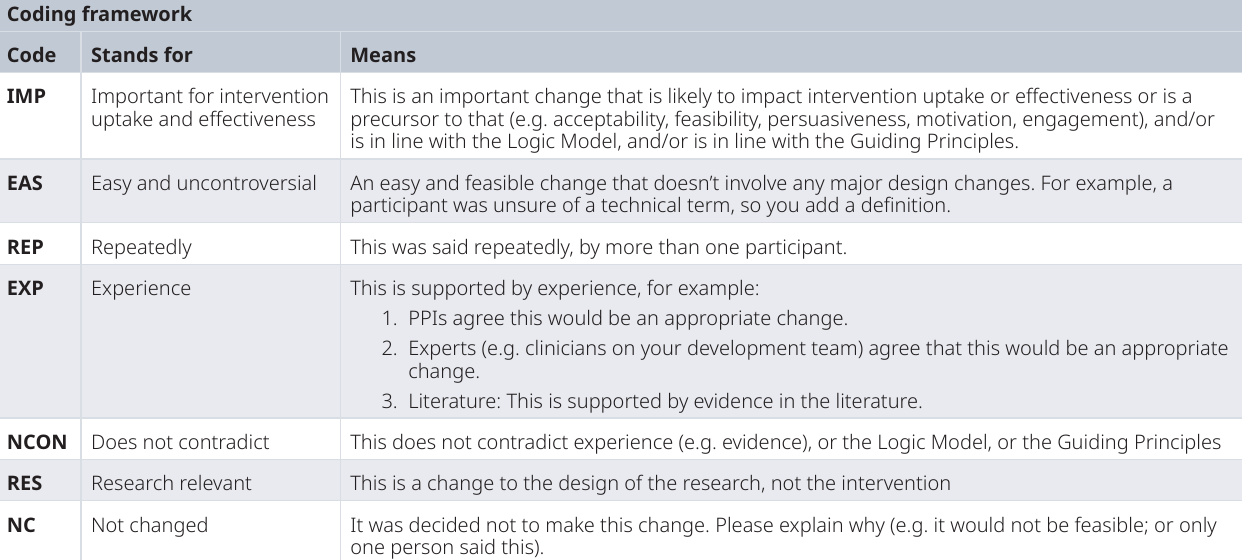
Table 1. Coding framework for Table of Changes. Coding framework Code Stands for